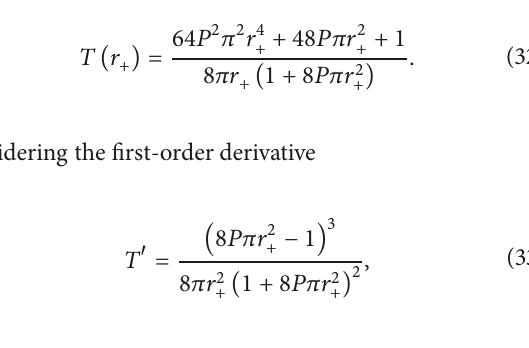
while the dashed line highlighting a lower bound of temper- ature destroys the 𝜆 line. It is easy to calculate the minimal temperature of six-dimensional HL AdS spherical black holes with 𝜖 = 𝜖 𝑐 , for which the temperature is reduced